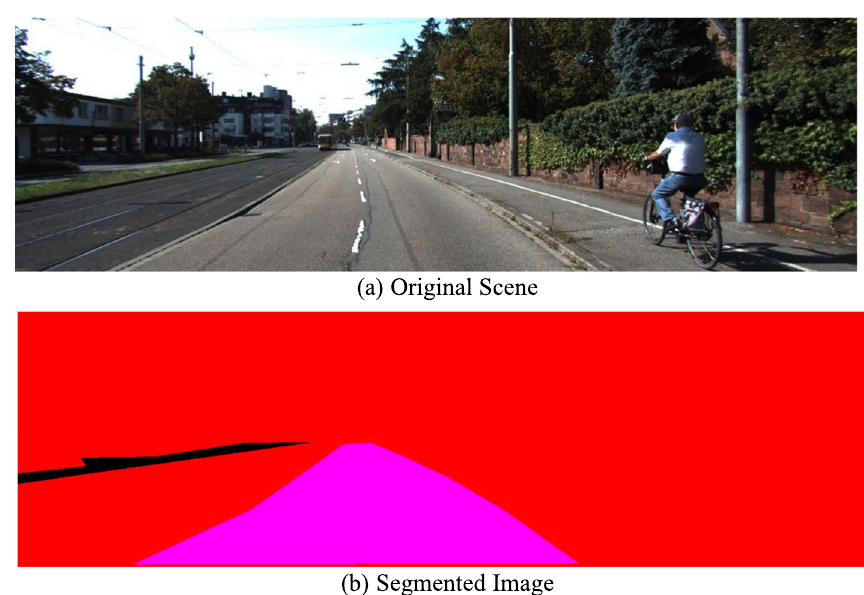
Fig. 4 Image of the driving environment captured by a camera in the KITTI dataset. a Original scene.